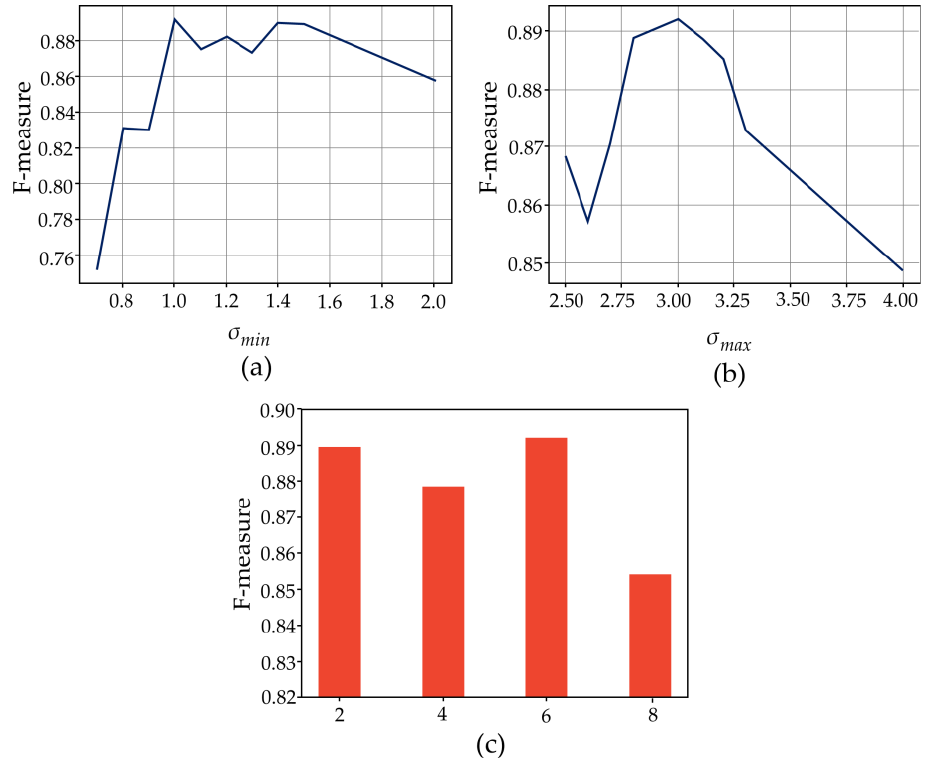
Figure 6. Evaluation of ( a ) σ min = 1, ( b ) σ max = 3, and ( c ) number of stages responsible for the refinement of the density map prediction.